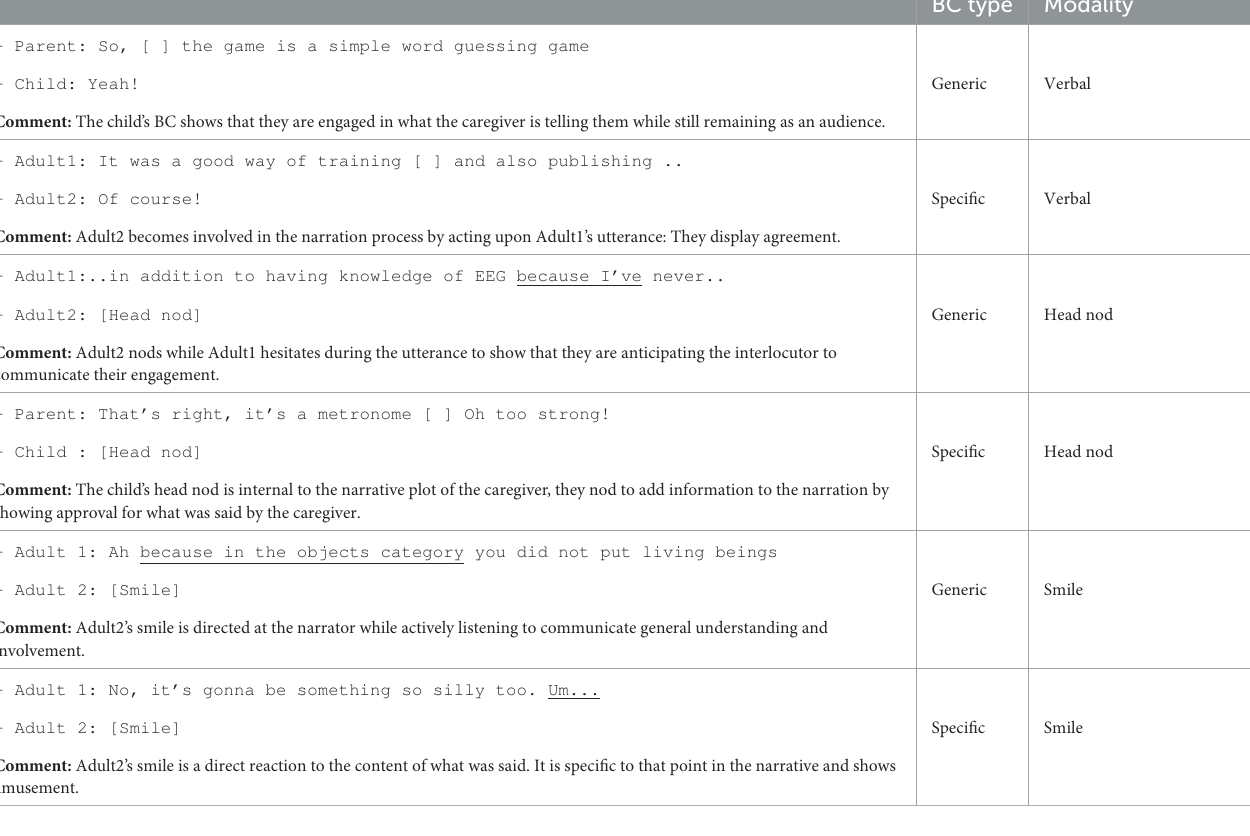
TABLE 2 Excerpts from conversations in our corpus (translated from French) exemplifying both types of BC in each of the three modalities we consider in this study. BC either occurs during a pause “[ ]” in the speaker’s turn or it overlaps with a segment of the speaker’s speech (the underlined part). The comment explains the decision to classify the BC as generic or specific, following the distinctions made in Bavelas et al.